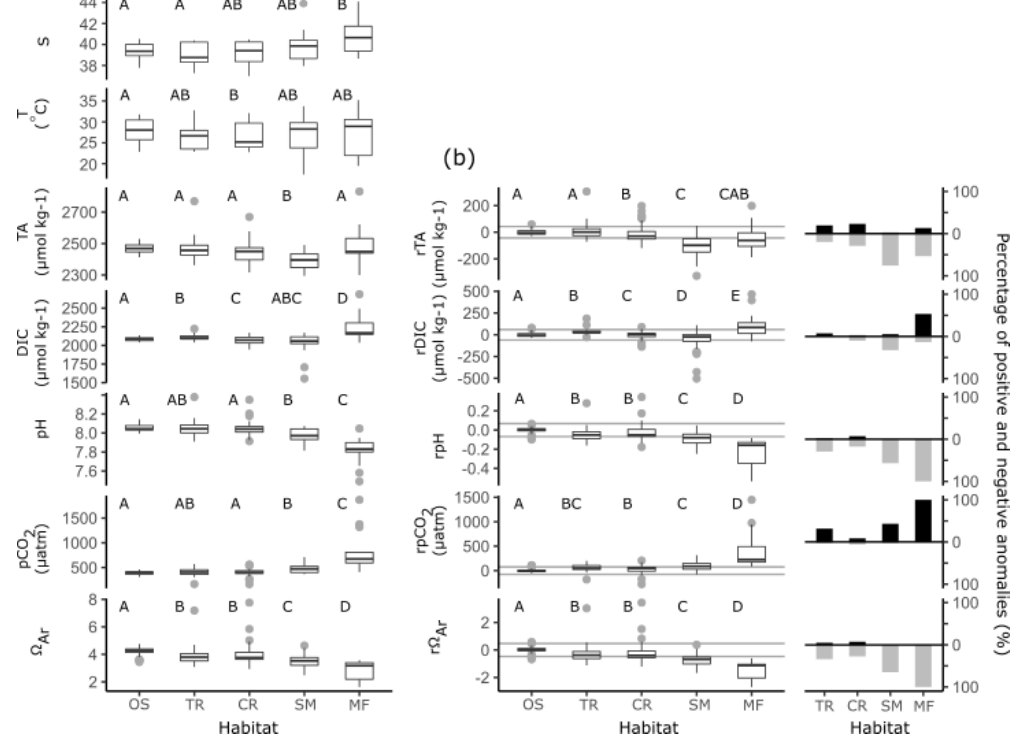
Figure 6. Box-plot distributions of (a) observed S , T , carbonate parameters and (b) non-conservative carbonate system residuals which are presented by the habitat group: offshore (OS), transition waters (TR), coral reef (CR), seagrass meadow (SM) and mangrove forest (MF). Each box plot displays the median, the first and third quartiles, and whiskers that extend to the mean ± 1 . 5 times the inter-quartile range. Grey dots represent observations that extend outside the whiskers of the box plot. Grey lines in panel (b) indicate the upper and lower bounds of the 99% PI defined by offshore observations. The proportion of ecosystem anomalies (%) observed in both the positive and negative directions are presented alongside and to the right of box plots in panel (b) (Table S4). Grouping letters (A–D) assigned above box plots indicate the results of post hoc bootstrapped t tests, summarised from statistics presented in Table S5. If tests showed significant similarities at the 0.05 significance level with another habitat across a variable they were assigned the same letter. Table 1. Intercept ( ± SE), slope ( ± SE), correlation coefficient ( r 2 ), F statistics ( F ) and p values ( p ) of linear regressions of rTA versus rDIC for different subsets of coastal observations. This table complements the results displayed in Fig.